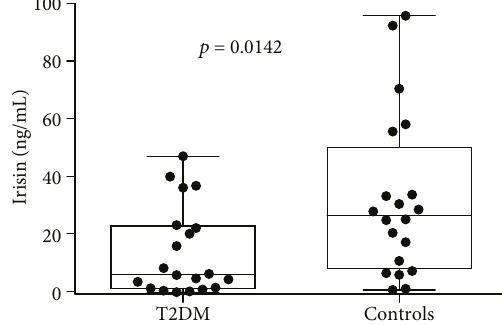
Figure 1: Irisin levels in studied groups. T2DM=type 2 diabetes Parameters. Table 3 shows Spearman ’ s correlation coe ffi cients between irisin concentration and the anthropo- metric and metabolic parameters. Irisin levels were found to be inversely correlated with height ( r = − 0 380 ), weight ( r = − 0 391 ) ( p < 0 05 ). Regarding metabolic and clinical